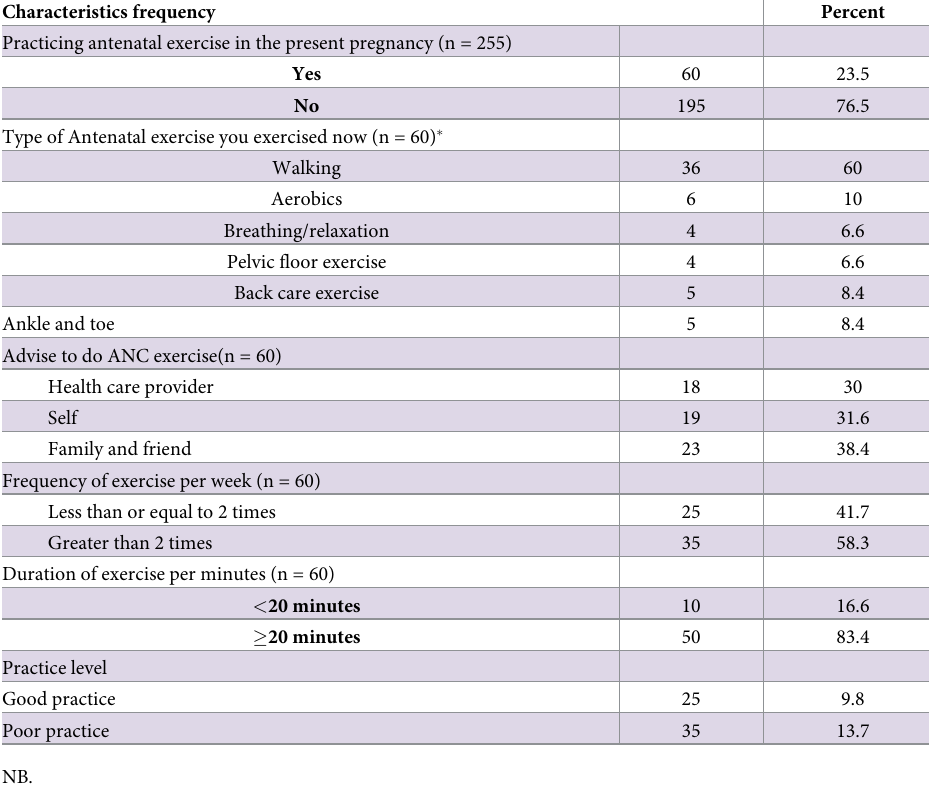
Table 4. Practice of antenatal exercise during pregnancy among pregnant women in Mekelle health centers, Tigray Ethiopia, 2020. Characteristics